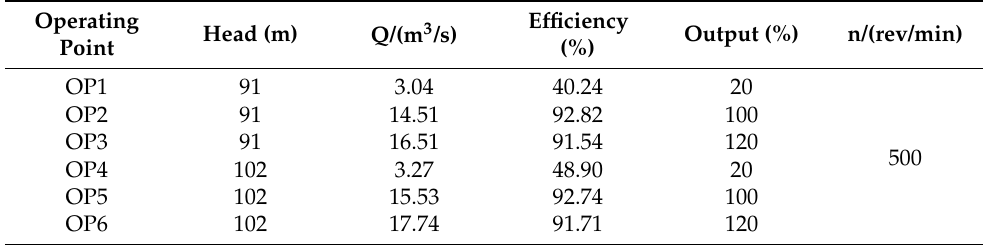
Table 4. Operating points in CFD